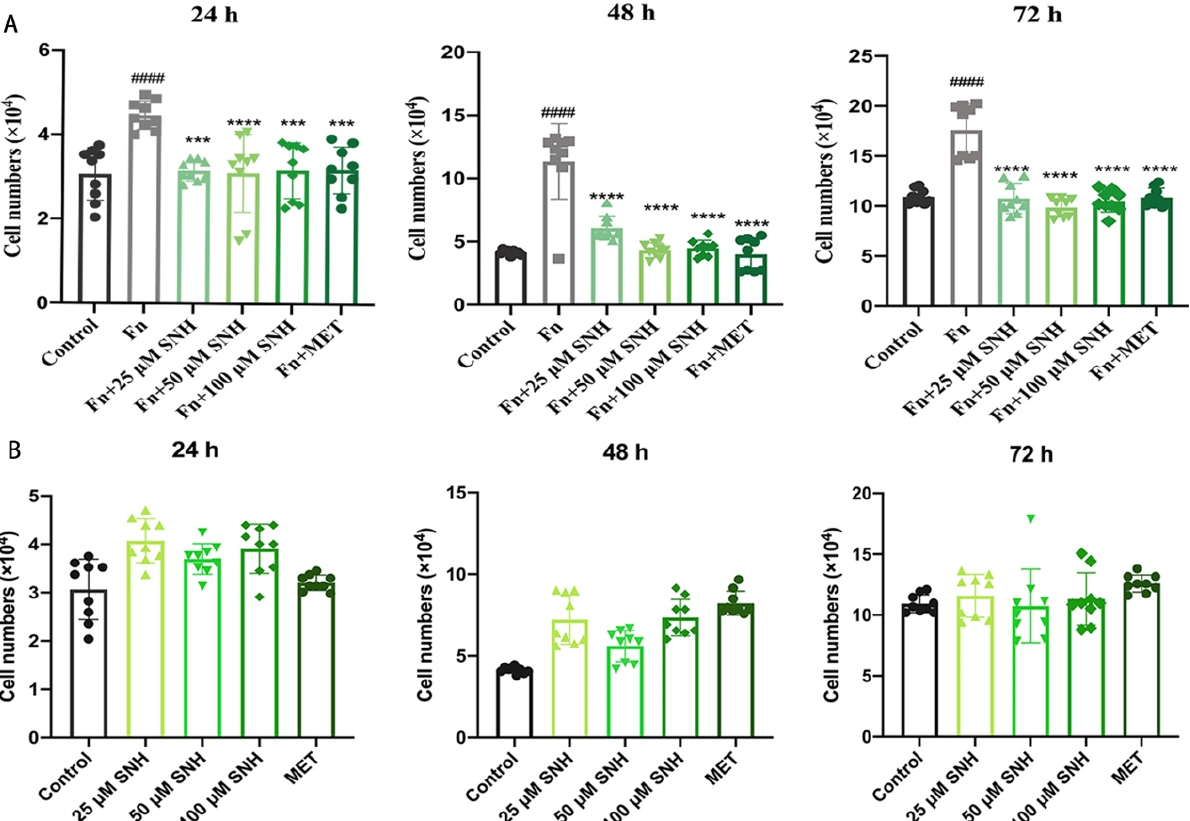
Figure 4. Effects of SNH on the proliferation of human colon cancer cells co-cultured with Fn. ( A ) Cell viability analysis of SNH on the proliferation of human colon cancer cells HCT116 co-cultured with Fn at the indicated time, metronidazole (MET) was used as a positive control. ( B ) Effects of SNH on the proliferation of HCT116 cells without Fn at 24 h, 48 h and 72 h, respectively. Each experiment was performed independently three times. All data were shown mean ± SD and p -value < 0.05 was considered statistically significant. *** p < 0.001, **** p < 0.0001, vs. Fn group. #### p < 0.0001, vs. Control.